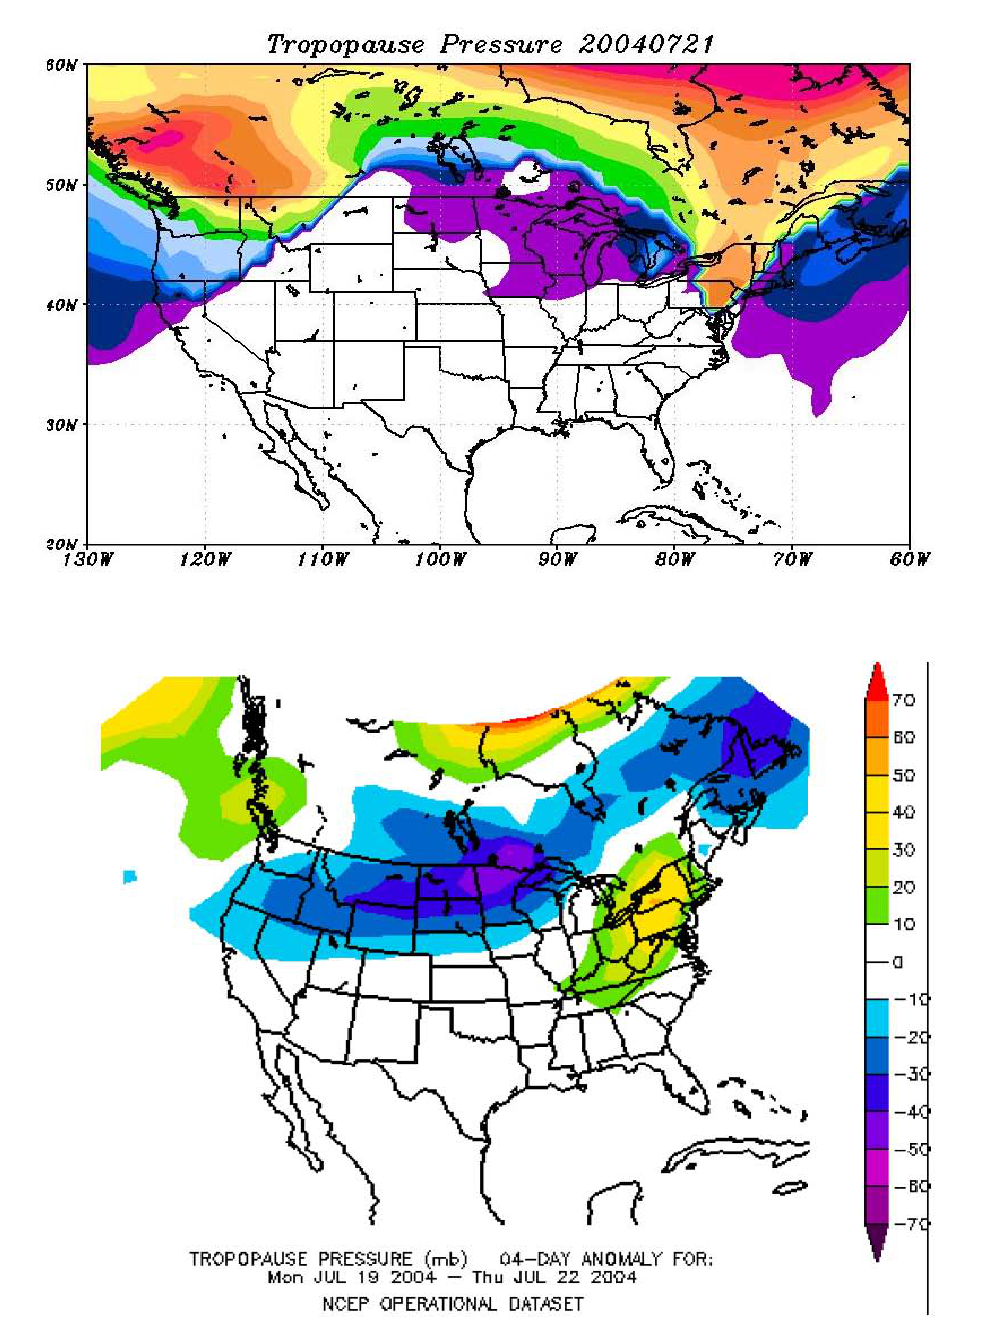
Figure 14. (Top) The NCEP 1° × 1° tropopause pressure on 21 July 2004. (Bottom) The 4-day anomaly (which was calculated by subtracting the climatology data of 1979–1995) of tropopause pressure from NCEP daily analysis data. The Northeast showed the positive anomaly of tropopause pressure (mean lower tropopause height) during 19–22 July